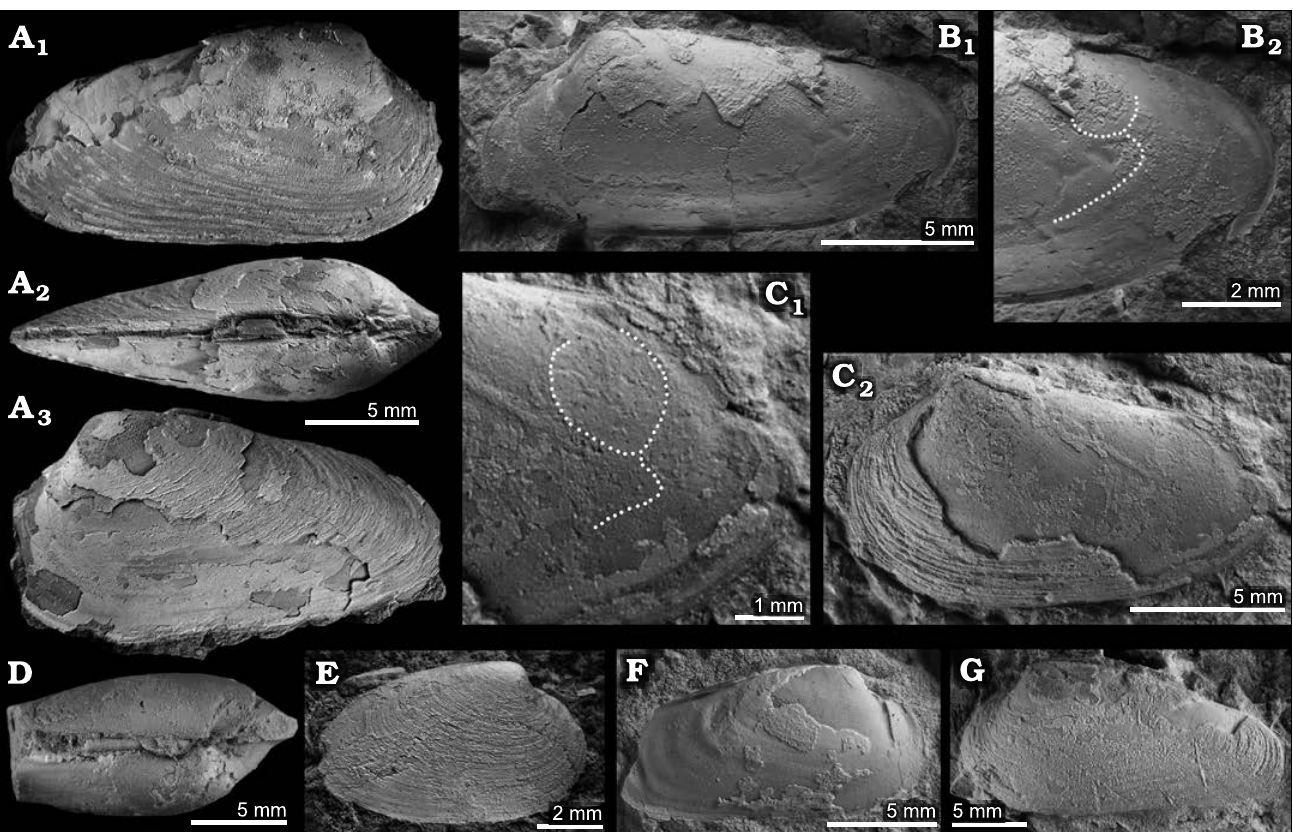
Fig. 2. The vesicomyid bivalve Squiresica knapptonensis (Amano and Kiel, 2007) from the West Fork Satsop seep deposit, lower Oligocene, Lincoln Creek Formation, western Washington, USA. A . NRM PAL Mo 195149, articulated specimen with partially preserved shell, in lateral (A 1 , A 3 ) and dorsal (A 2 ) views. B . NRM PAL Mo 195150, left valve embedded in matrix, with partially preserved shell; B 2 , close-up showing pallial line and anterior adductor muscle scar (dotted line). C . NRM PAL Mo 195151, left valve embedded in matrix, with partially preserved shell (C 2 ) and with posterior adductor muscle scar barely visible (dotted line in C 1 ). D . NRM PAL Mo 195153, articulated specimen showing inflation and ligament. E . NRM PAL Mo 195152, small specimen with fully preserved shell, view on outer shell surface. F . NRM PAL Mo 195154, right valve embedded in matrix, with partially preserved shell, showing pallial line and anterior adductor muscle scar. G . NRM PAL Mo 195155, left valve with mostly preserved shell.